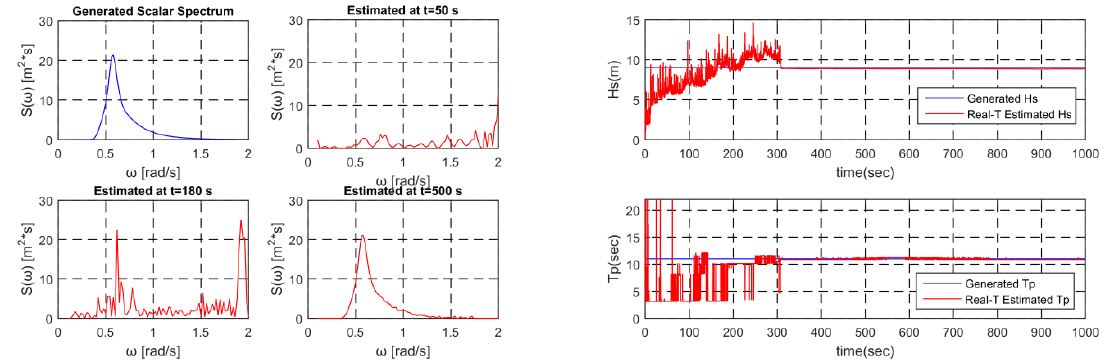
Figure 31. Generated and estimated spectrum / Evolution of parameters (Sea sate 3, Hs = 9 m, Tp = 11 s).